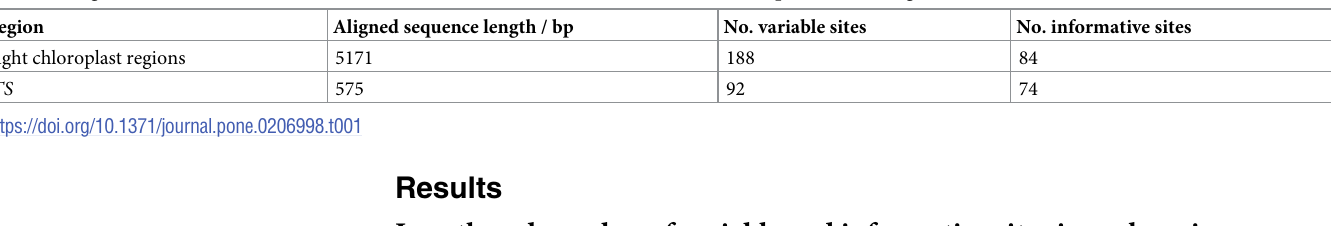
Table 2. Pairwise distances, based on K2P distance, between the different Populus sections. Tacamahaca